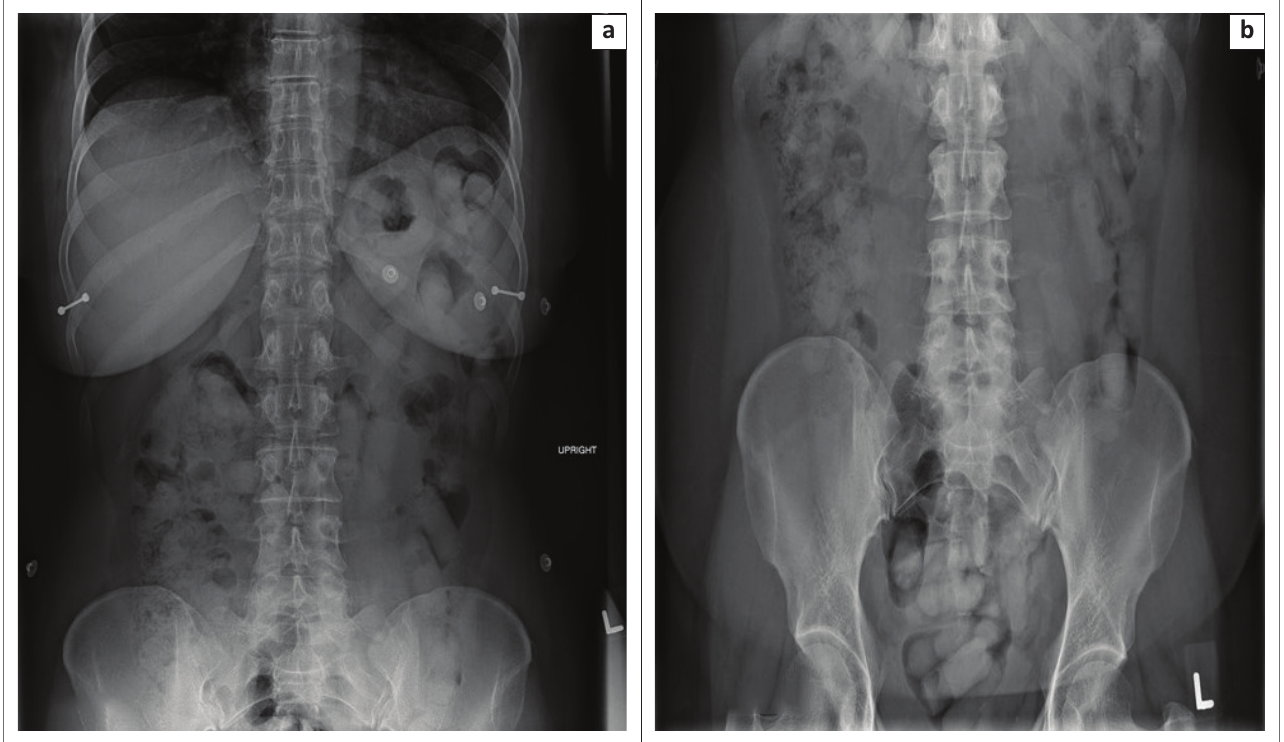
FIGURE 11: (a and b) Abdominal radiographs of packages containing narcotic materials in a 45-year-old (Figure 11a); (3) the ‘parallelism sign’ – firm narcotic packs aligning parallel to each other in the intestinal lumen; (4) the ‘rosette sign’ – refers to air trapped in the knot of the drug packet; (5) the ‘halo sign’ – a complete rim of blurred lucency surrounding the drug packet 43,44 ; (6) the ‘black crescent sign’ – a crescent of air around the drug packet; and (7) the ‘lucent triangle sign’ – representing air in the interface between drug packets or with the bowel wall. The ‘double condom’ and ‘halo’ signs that have traditionally been used for detecting packets containing solid drugs, are also effective in detecting liquid cocaine.